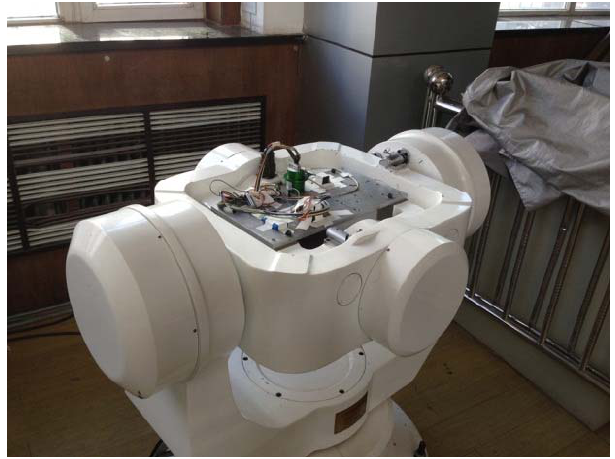
Figure 5. Three ‐ axle rotary table layout of the magnetic induction angular rate sensor. Figure 5. Three-axle rotary table layout of the magnetic induction angular rate